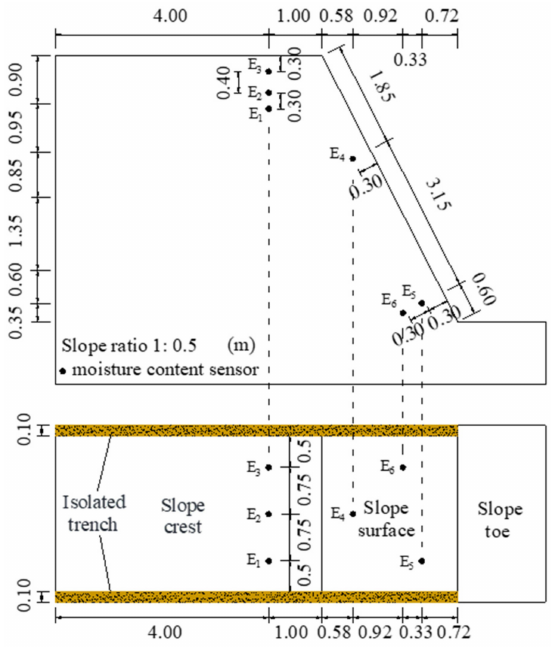
Figure 4. Schematic diagram of moisture sensor layout.